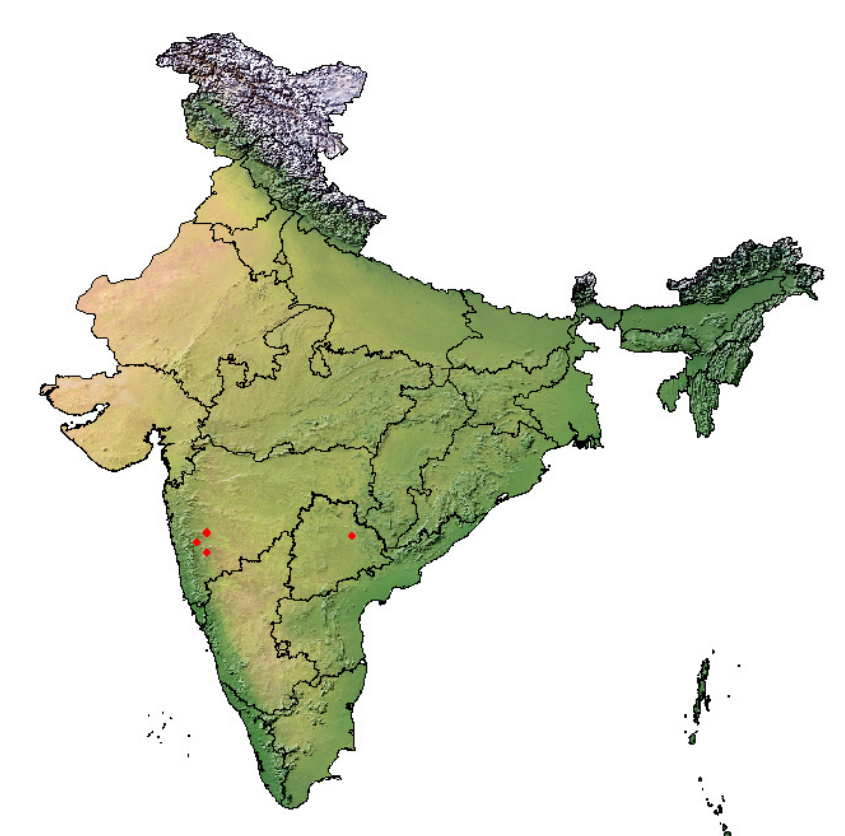
Figure 5. Distribution of Deccanometrus xanthopus (Pocock, 1897) in India